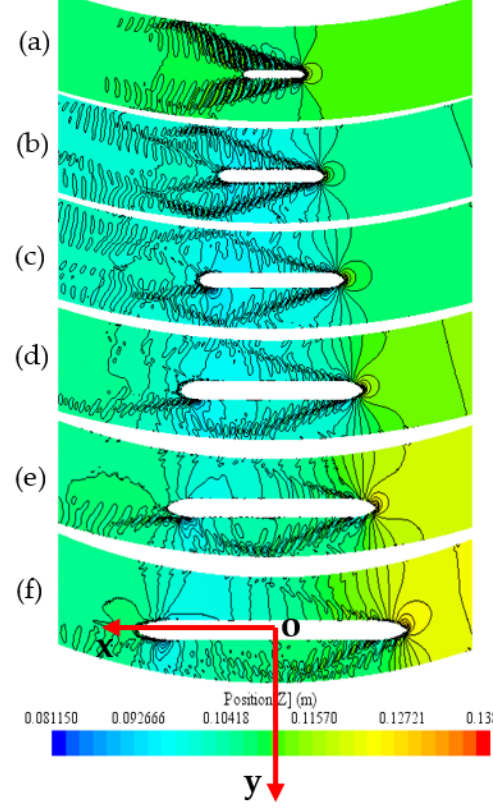
Figure 15. Free surface elevation contours of ship type variation. ( a – f ): L pp = 1.54 m, 2.68 m, 3.6 m, 4.4 m, 5.4 m, 7.2 m corresponding beam = 0.202 m, 0.328 m, 0.38 m, 0.45 m, 0.45 m, 0.45 m.